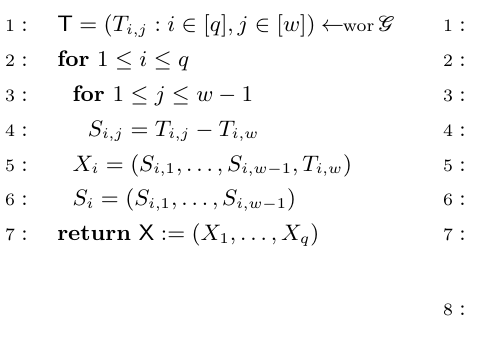
Figure 3.2: X and Y are extended random variables of S and U